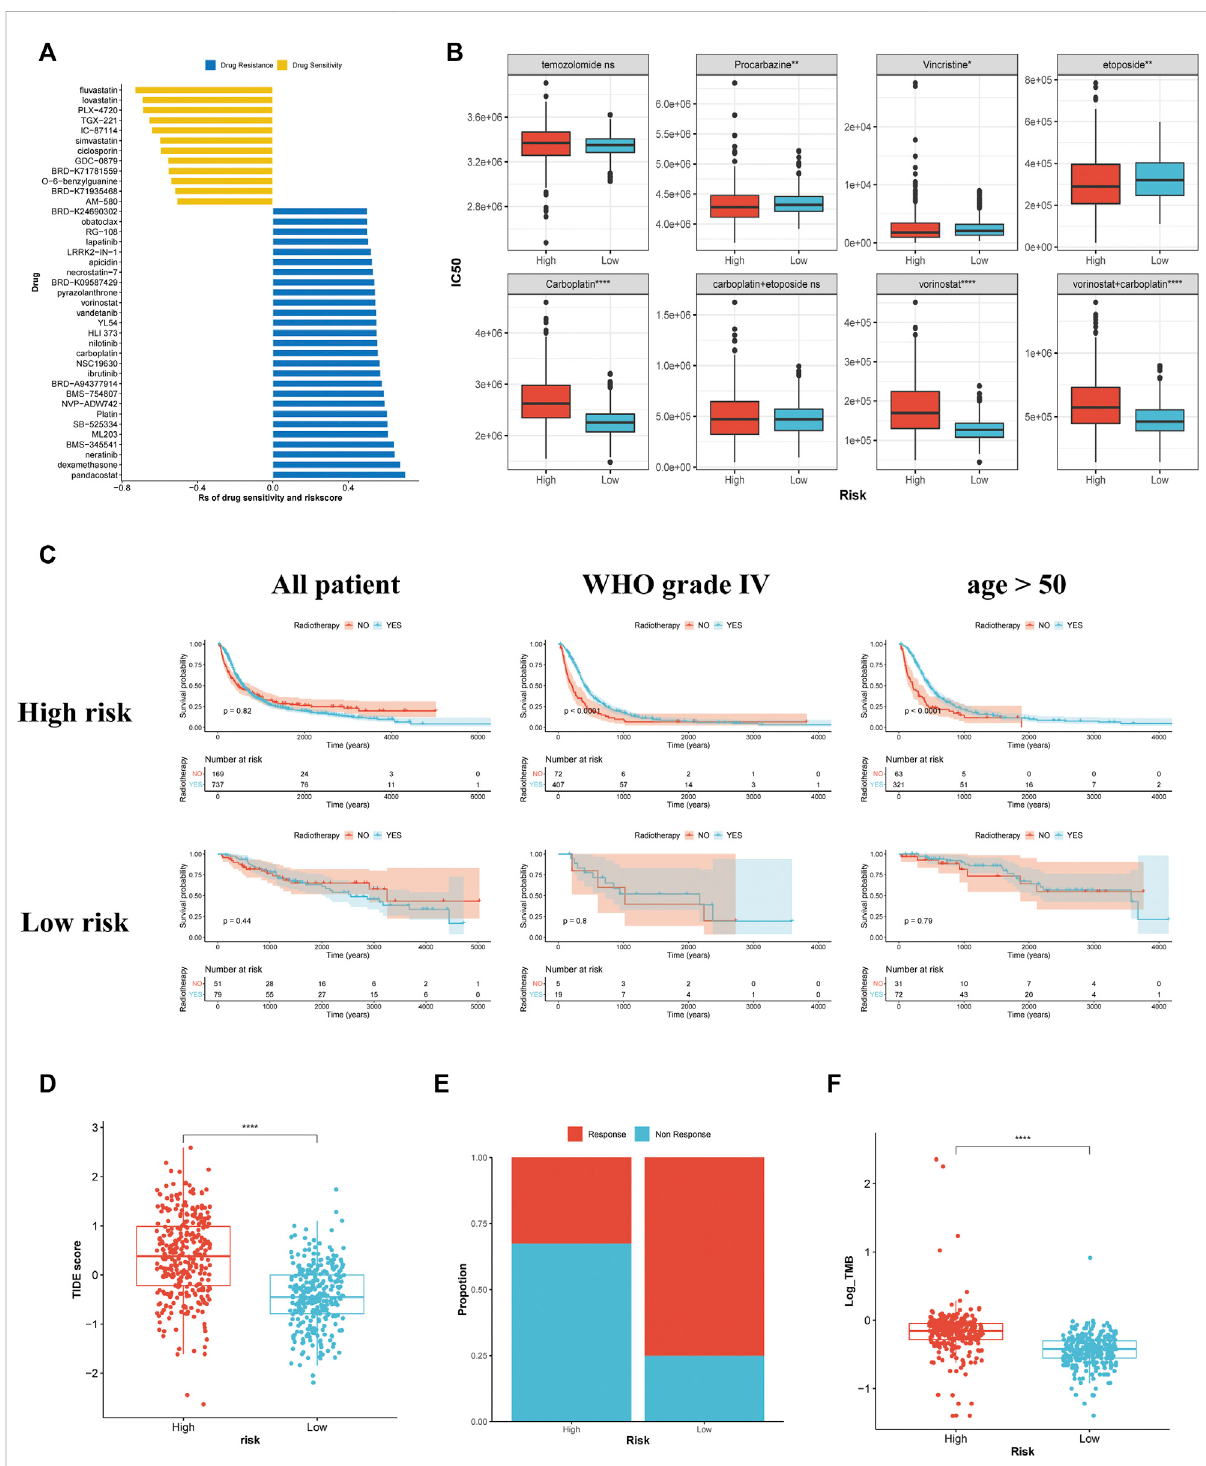
FIGURE 8 Association between the risk strati fi cation and drug sensitivity, the effectiveness of radiotherapy, and the predictive response to immunotherapy. (A) The association of the risk scores with drug sensitivity evaluated using Spearman ’ s analysis. Each row represents a drug. The lengthoftherowindicatesthecorrelation,indicatingthattheriskscoreisrelatedtodrugresistance(Rs > 0)ordrugsensitivity(Rs < 0). (B) TheIC50of theanti-gliomachemotherapeuticdrugsinthehigh-andlow-riskgroups. (C) TheKMcurvesforallpatients,patientswithgliomaofWHOgrade Ⅳ , and patients aged > 50 years with or without radiotherapy in the high- and low-risk groups. (D) The TIDE scores of patients within the high- and low-risk groups. (E) The estimation of immunotherapy responsiveness in high- and low-risk groups. (F) The TMB levels of patients in the high- and low-risk